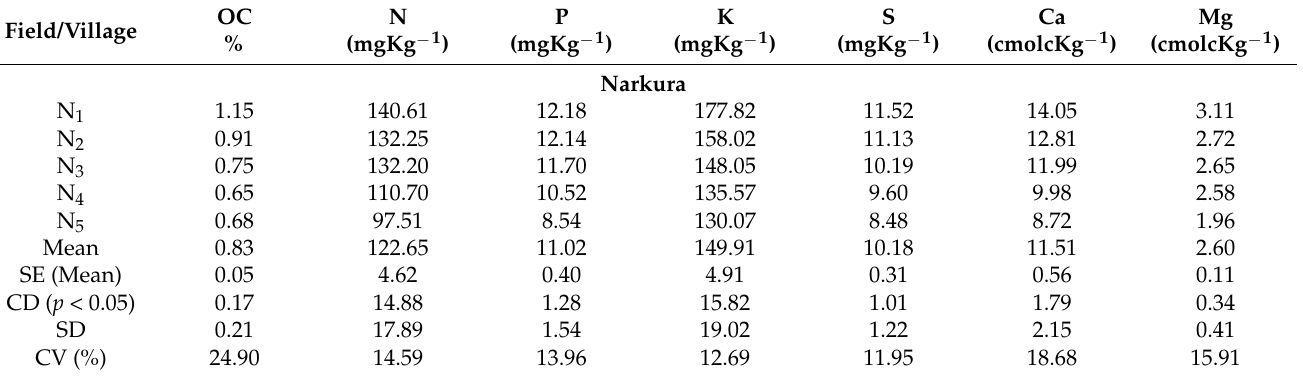
Table 3. Organic carbon and available nutrients in the soils of different